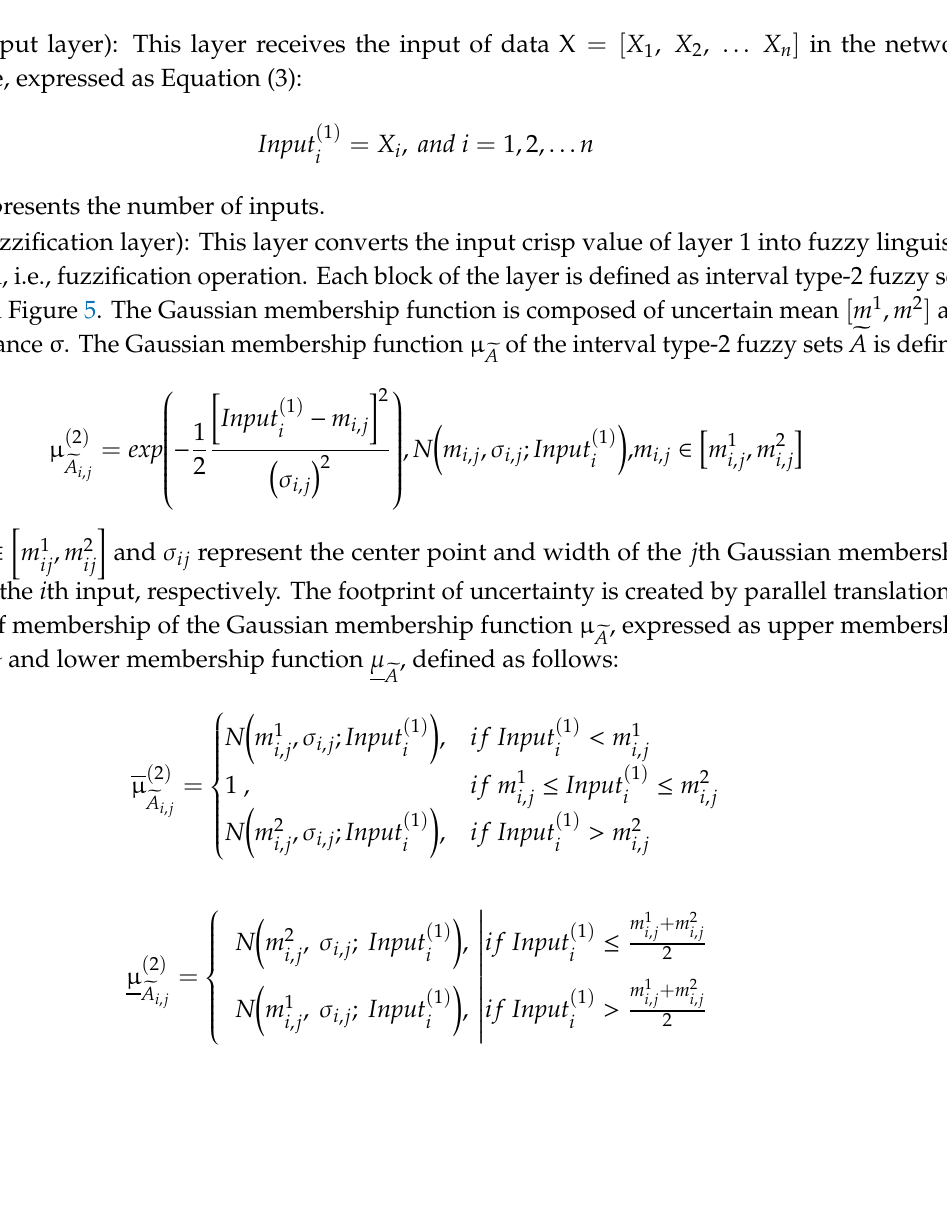
Figure 4. Architecture diagram of the Interval Type-2 Recurrent Fuzzy Cerebellar Model Articulation Controller (IT2RFCMAC) model.